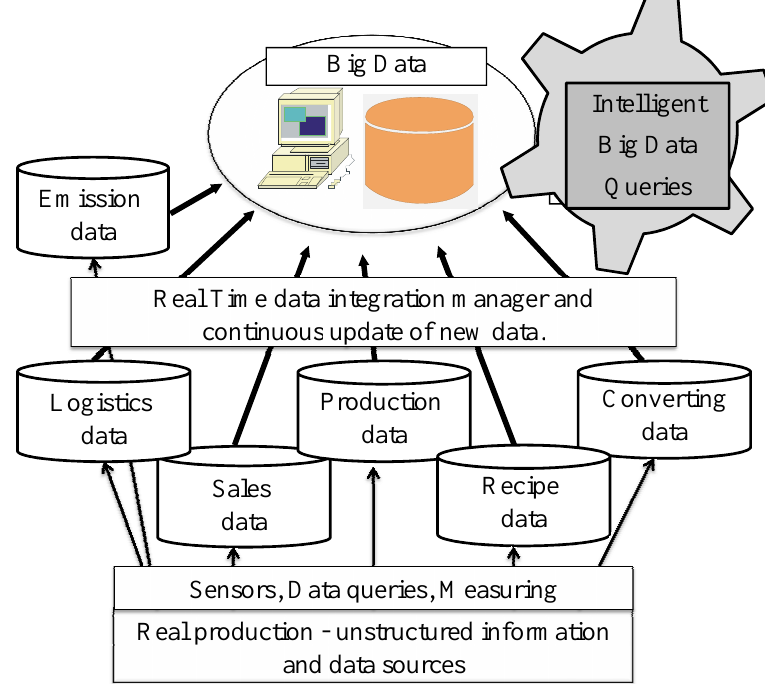
Figure 1. An integrated Big Data system in the process